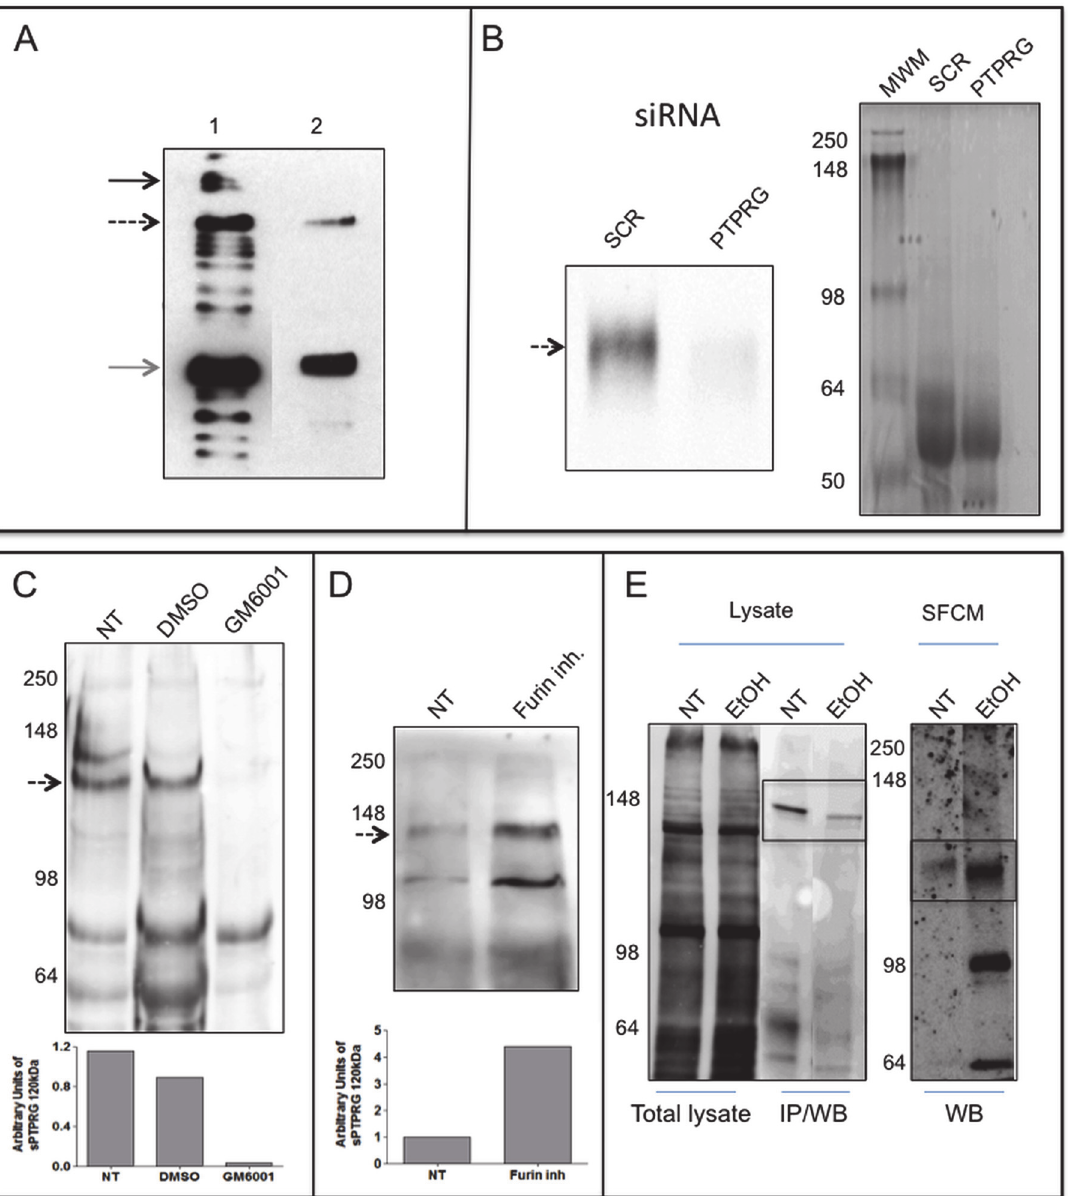
Fig 5. Expression and release of PTPRG by HepG2 cells. Panel A : WB with Rb anti-P4 of total lysate and supernatant of HepG2 cell line. Lane 1: 10 μ g total cell lysate of HepG2 cell line. Lane 2: serum-free conditioned medium of HepG2 after 100000×g ultra-centrifugation and TCA precipitation. Black arrow: full-length protein, dashed arrow: * 120 kDa isoform, gray arrow: * 90 kDa isoform. Panel B : WB with Rb anti-P4 of serum-free conditioned medium of HepG2 cells showing down regulation of sPTPRG by siRNA (siRNA PTPRG) in comparison with a scrambled sequence (SCR). Coomassie blue staining of serum-free conditioned samples demonstrating the loading on comparable amounts of material in both lanes. Panel C : serum-free conditioned medium (SFCM) of HepG2 cells. Left: Molecular weight marker. NT: untreated cells, DMSO: cells treated with vehicle (DMSO), or overnight with 12 μ M metalloproteinase inhibitor GM6001 (Ilomastat). Densitometric analysis of sPTPRG 120 kDa isoform related to a common aspecific band approximately at 70 kDa present in all samples ( below ). Panel D : cells treated overnight with 50 μ M furin inhibitor. Dashed arrow: * 120 kDa isoform. Below is the densitometric analysis expressed as fold increase versus control of the * 120 kDa band normalized against the total protein load. WB was performed with a chicken anti- PTPRG antibody[27]. Panel E : WB with streptavidin-HRP of cell-surface biotinylated HepG2 cells untreated (NT) or treated (EtOH) for 16 hours with 50 mM ethanol, lysed and immunoprecipitated with anti-P4 antibody (IP/WB, bands boxed). Lower levels of full length PTPRG is present in EtOH treated cells. The same antibody was used in WB analysis on the corresponding serum-free conditioned media precipitated with TCA/acetone (right panel, boxed). The * 120 kDa PTPRG isoform was detectable in SFCM at higher levels in comparison with untreated cells. The first two lanes represent total cell lysate before IP and demonstrate equal amount of protein and comparable surface biotin labeling of the two samples.